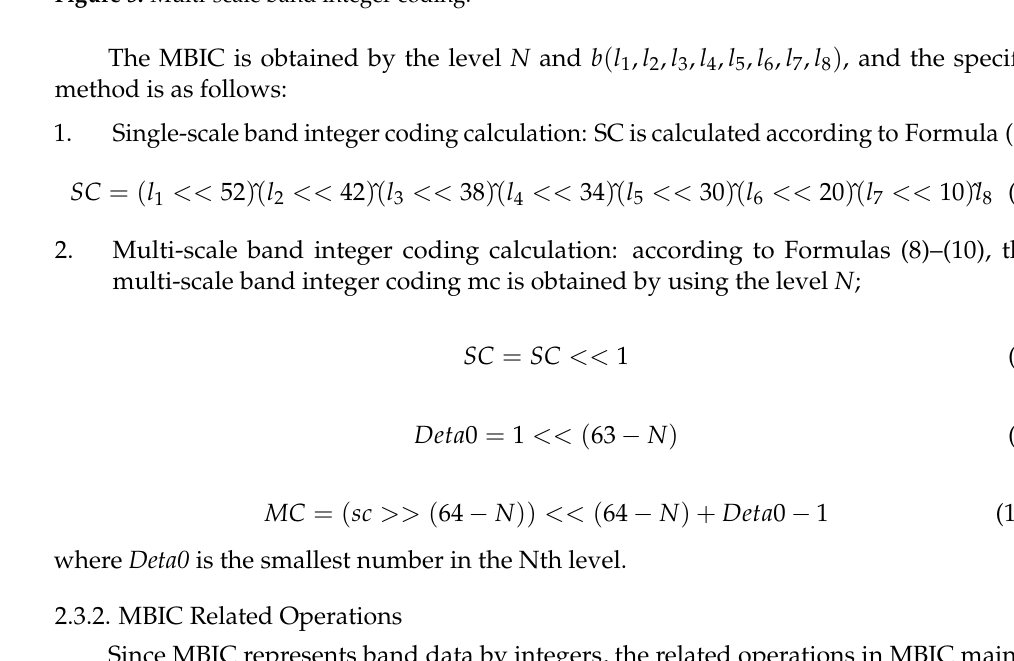
Figure 5. Multi-scale band integer coding.